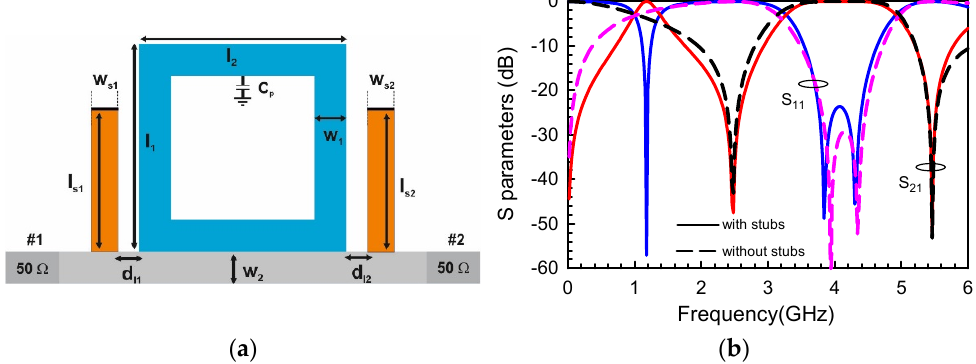
Figure 8. ( a ) Configuration of the unit filter cell ( b ) Comparison of calculated S parameters with/without short-circuited stubs.